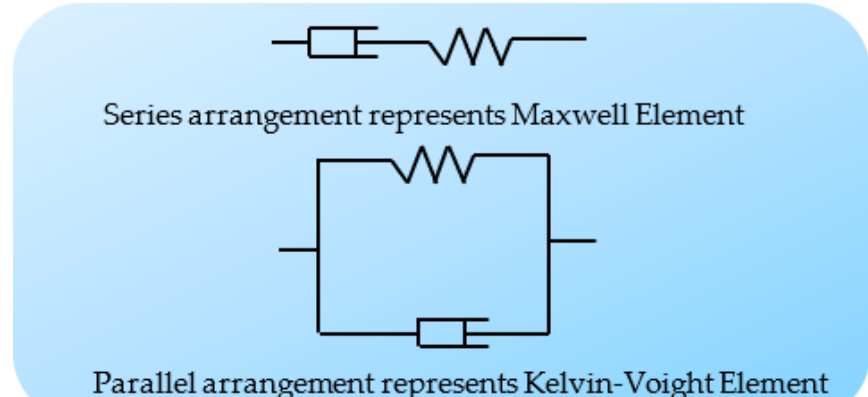
Figure 1. Simple rheological models of viscoelastic behaviour.